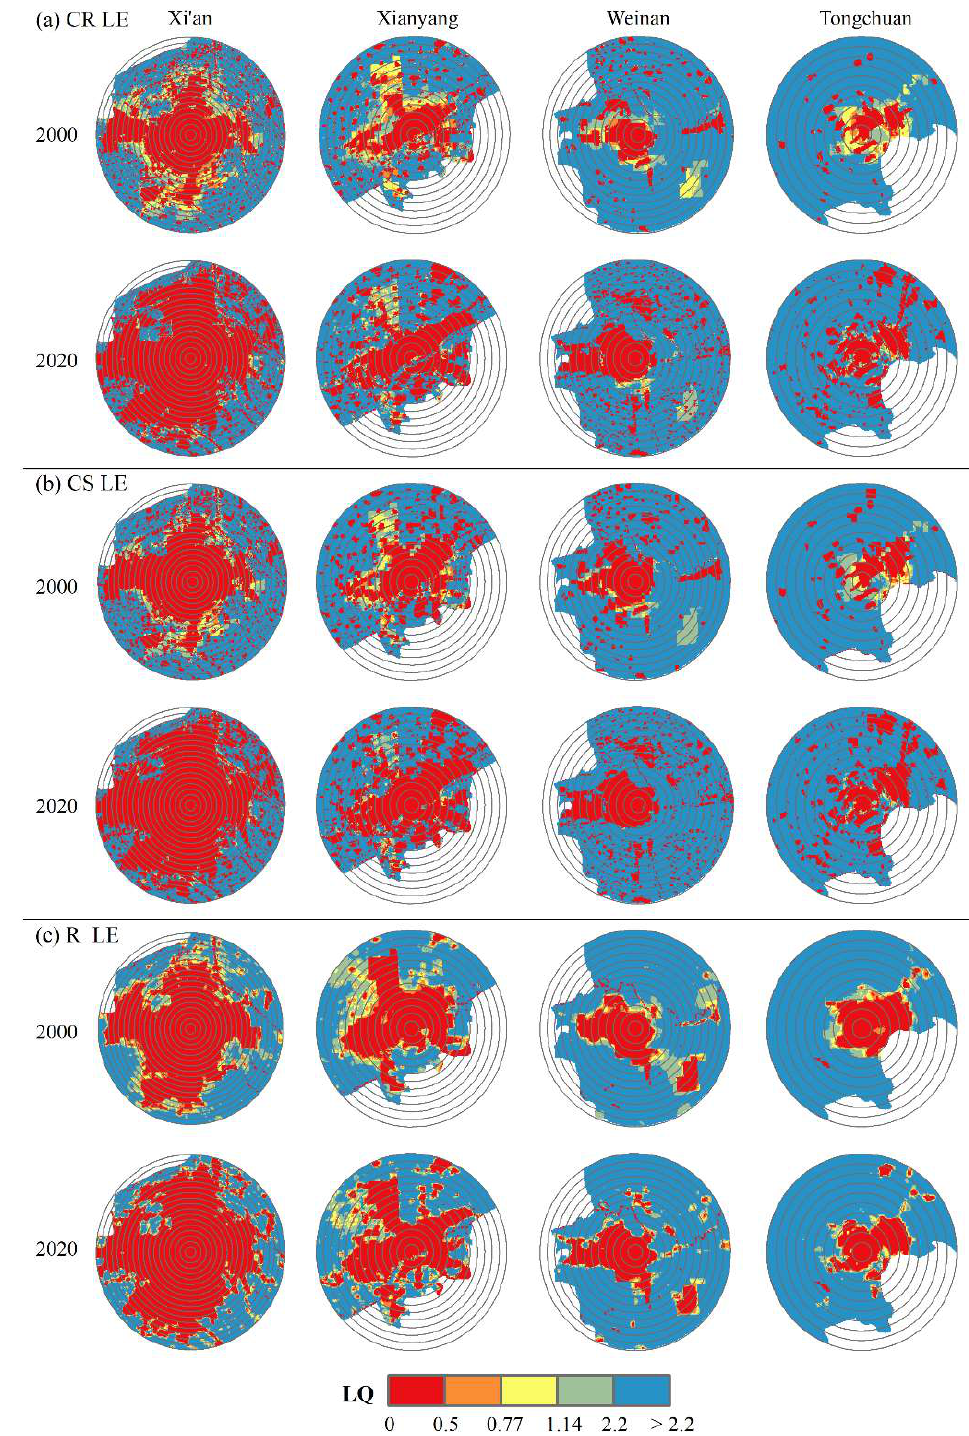
Figure 8. The location entropy (LE) patterns of climate regulation (CR) ( a ), carbon sequestration (CS) ( b ), and recreation (R) ( c ) in 2000 and 2020 in the XMA.